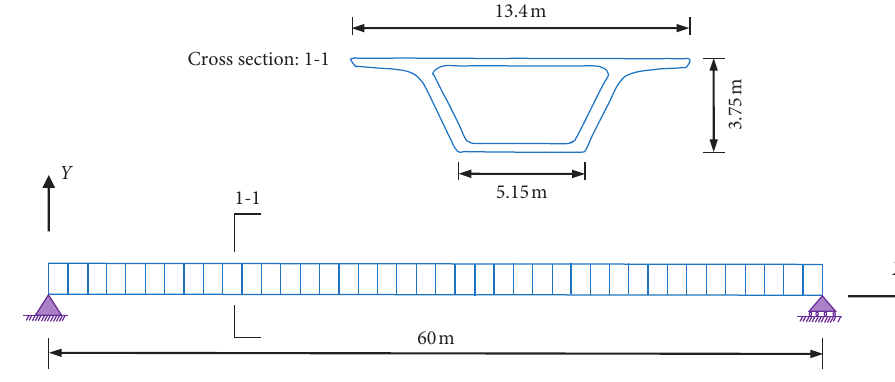
Figure 2: Geometry and boundary conditions of the example beam problem. Table 1: Random field parameters of the mass density ρ and Young’s modulus E of the example beam at the reference